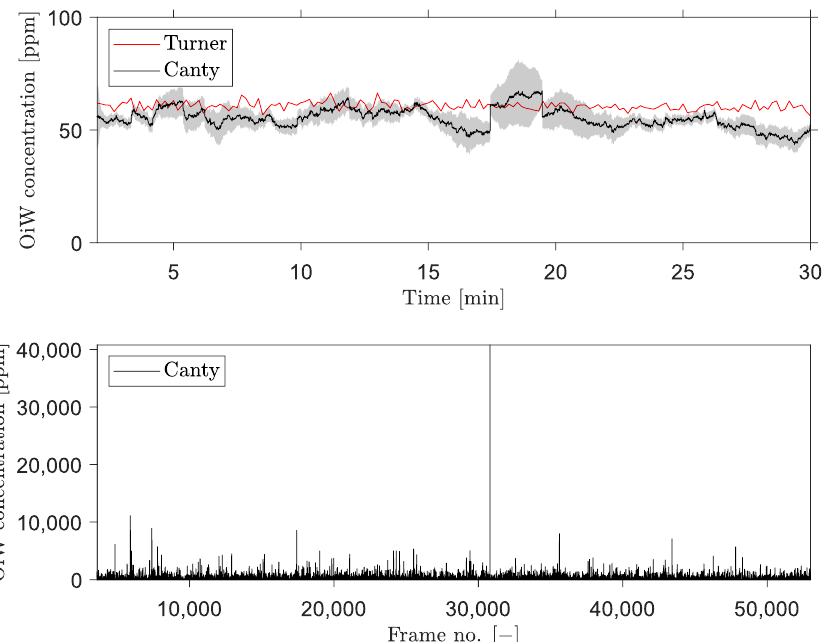
Figure 17. Real-time OiW concentration measurements calculated using a trailing moving average window of 1 min of the post-processed oil volume ratio in each image captured by C 3 . Top graph shows the real-time measurement measured by C 1 and C 3 . A 95% confidence interval of the averaging window is shadowed behind the signal. Bottom graph shows the volume concentration of each frame captured.